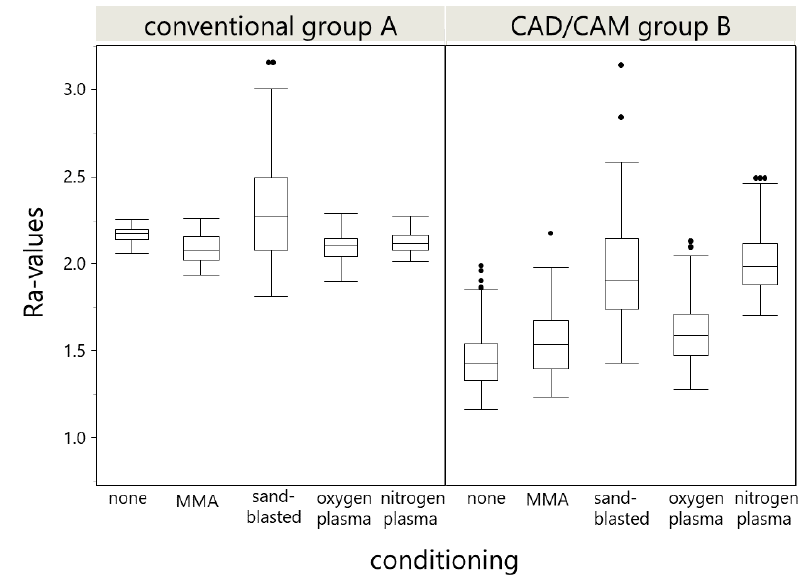
Figure 4. Boxplots of the Ra values ( µ m) of the surface modifications. Data are based on one specimen per group derived from 121 profiles every 25 µ m over a 9 mm 2 in the center of the specimen. There was no statistical significance between the Ra values of oxygen and MMA conditioning within Group A. All Ra distributions were statistically significantly ( p < 0.01) different from each other within Group B. Furthermore, the comparison of the conditioning revealed a statistical difference ( p < 0.0001) between Groups A and B.